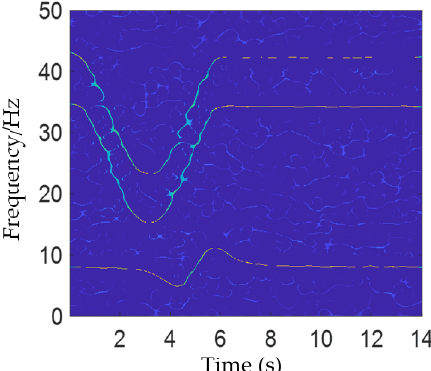
Figure 7. TF distribution of the simulated signal with noise based on SET.